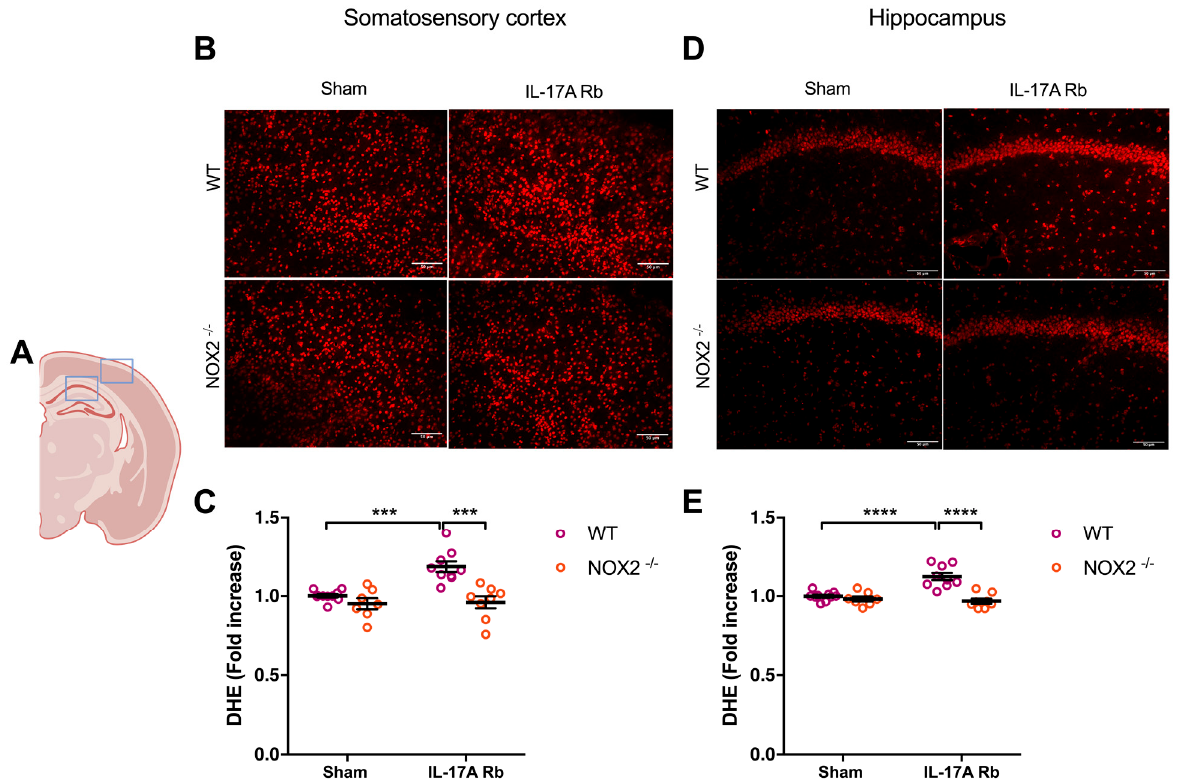
Figure 6. NOX2 deletion prevents oxidative stress production induced by IL-17A . Superoxide an- ion production was quantified using DHE in C57BL/6WT or NOX2 -/- male mice receiving IL-17A Rb through an osmotic minipump (50 pg/kg/h, 7 days). ( A ) the acquisition area representing the soma- tosensory cortex (right box) and the CA1 of the hippocampus (left box). Representative micrographs of DHE staining in ( B ) the somatosensory cortex and ( D ) the CA1 of the hippocampus (50 μ m scale). The graphs depict the ratio of fluorescence compared to control in the ( C ) somatosensory cortex and ( E ) the hippocampus. Data were analyzed using an ANOVA for factorial design followed by a Bon- ferroni post-test. *** p < 0.001 and **** p < 0.0001; n = 7–10 per group.